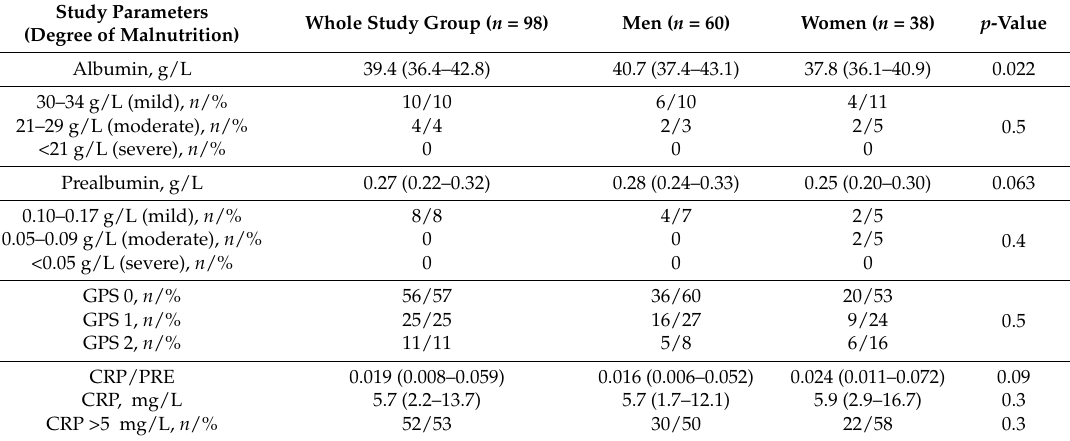
Table 2. The characteristic of the selected markers of malnutrition and inflammation. Study Parameters (Degree of